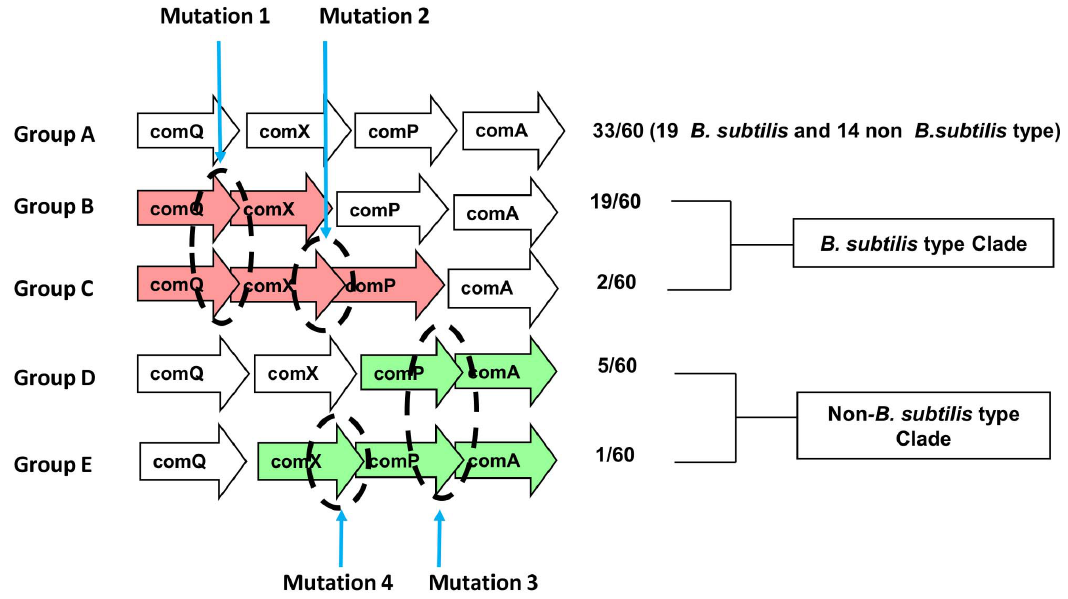
Figure 3. The gene overlaps within the comQXPA loci in B.subtilis type and non- B.subtilis type clade, overlaps are shown in color. For the definition of the clades, see phylogenetic analysis. The numbers indicate the frequency of the type/the number total occurrences (i.e. 60).